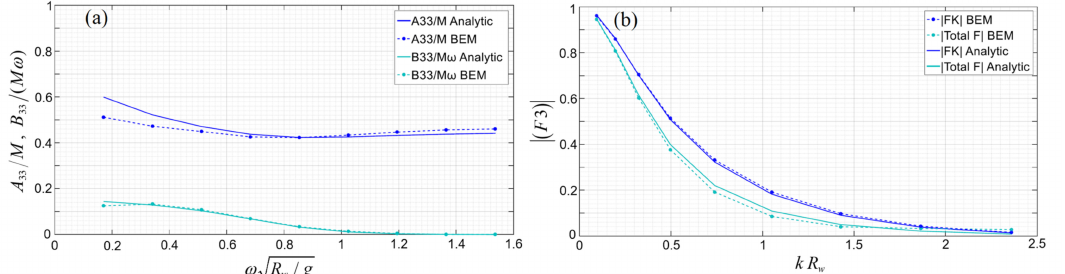
Figure 8. Comparison of BEM results (shown by using dots) with the analytical solution (solid lines) for heaving cylindrical floating body with parameters α / h = 1/3.5, d / α = 3/2, c / h = 4/7, concerning ( a ) the normalized hydrodynamic coefficients (added mass and damping) vs. non- (cid:112) R w / g , and ( b ) normalized Froude–Krylov and total excitation forces vs dimensional frequency ω non-dimensional wave number ( kR w ).